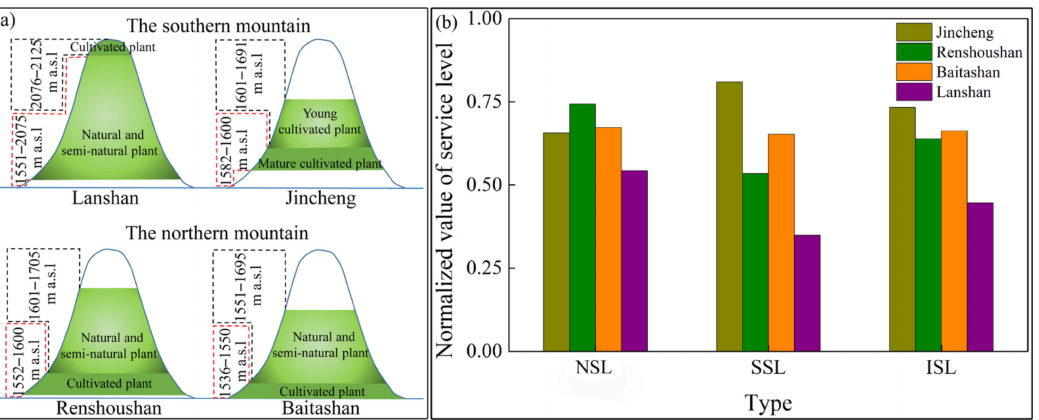
Figure 8. ( a ) Spatial distribution of different plant community types and ( b ) their natural service level (NSL), social service level (SSL), and integrated service level (ISL) within each